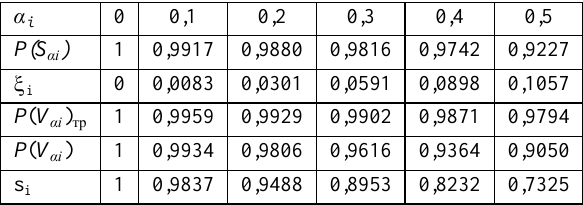
Fig.1. Photo of a processed surface with defects.